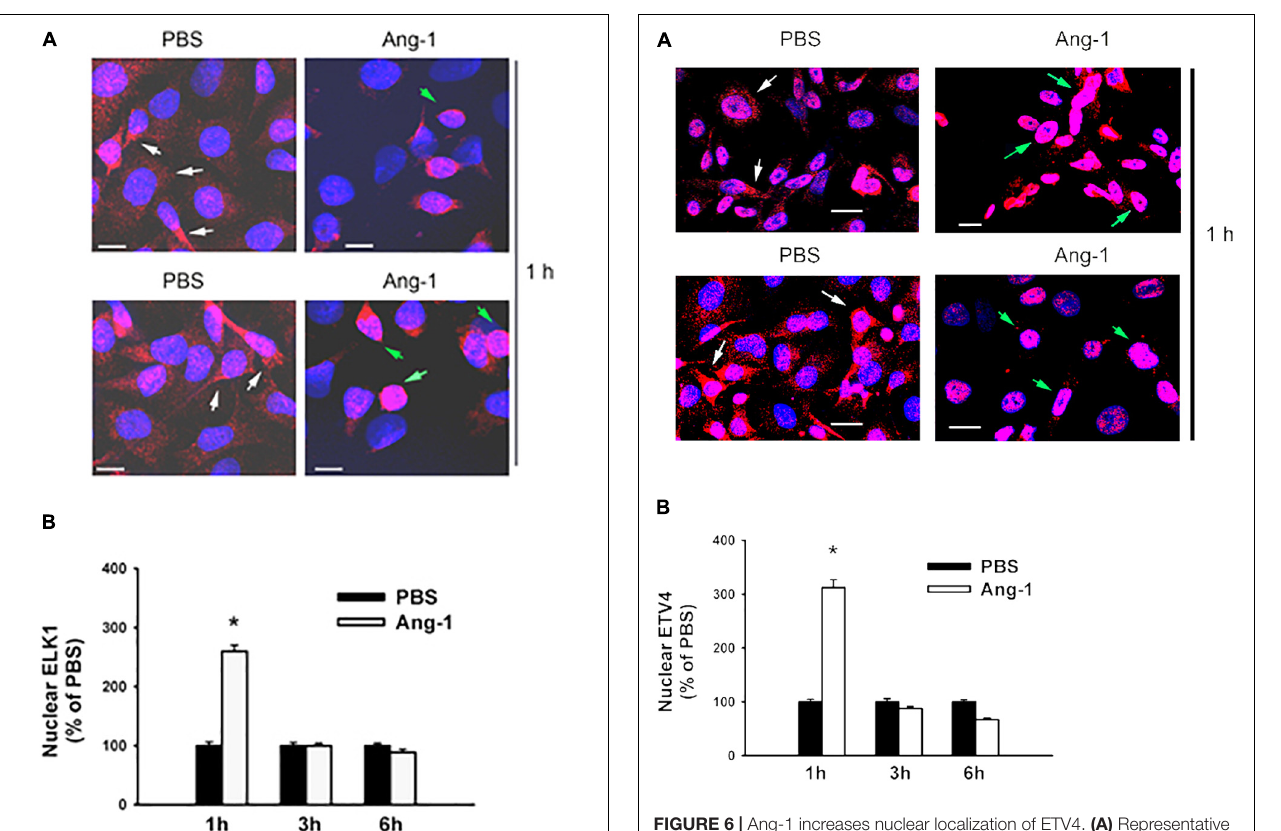
FIGURE 6 | Ang-1 increases nuclear localization of ETV4. (A) Representative immunofluorescence images of ETV41 protein (red color) and nuclear staining (DAPI, blue) in HUVECs exposed to PBS or Ang-1 for 1 h. Green arrows indicate cells with nuclear ETV4 staining; white arrows indicate cells with strong cytosolic ETV4 staining. (B) Fluorescence intensity of nuclear ETV4 in HUVECs exposed to PBS or Ang-1 for 1, 3, or 6 h. Values are means ± SEM, expressed as percent of PBS. * P < 0.05, compared to PBS. N > 130 cells per group. White bars indicate 20 µ